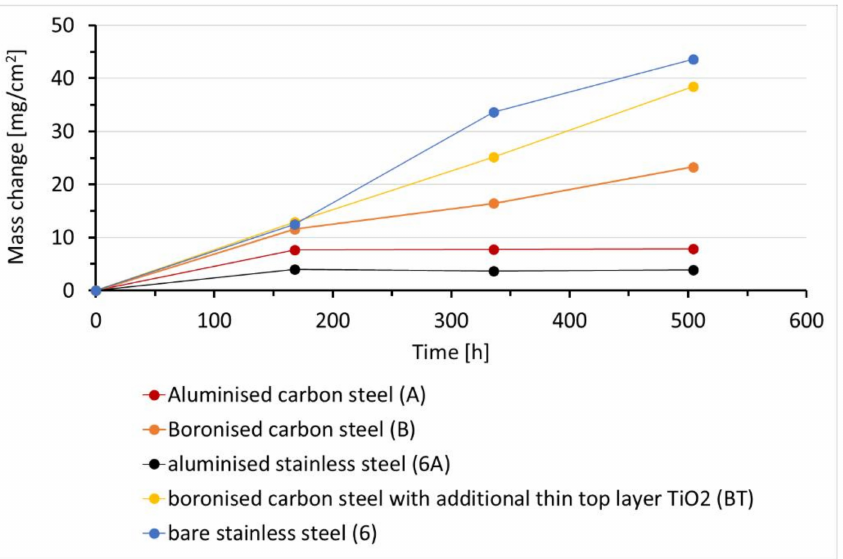
Figure 4. Specific mass change vs. time (kinetic curves) for the studied samples after sulfidation- oxidation in H 2 S-air at 500 ◦ C for 504